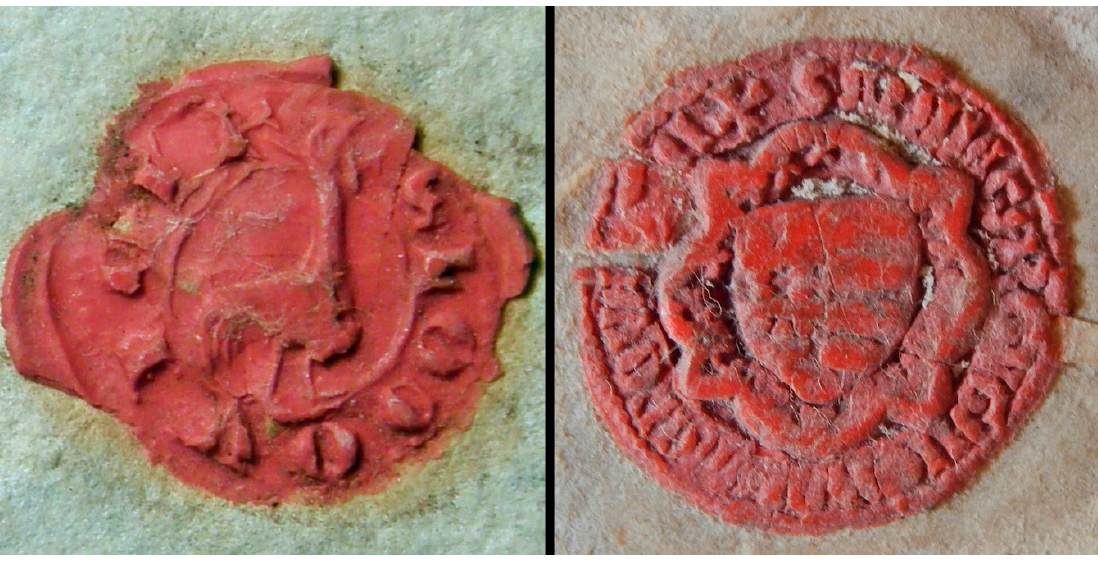
Figure 3. Signet ring seal of Louis the Great from 1360 ( left side ). Archiv mesta Košice, Archivum Secretum, “T” Jesznei, Nr. 26. The secret seal of Queen Mary of Hungary from 1387 ( right side ). Štátny archív v Prešove, Archive of the Drugeth family of Homonna, Nr. 14. Red wax seals of foreign rulers from around the country appear on the diplomas kept in Hungarian archives; for example, the seal of the Serbian despot Đ ura đ Brankovi´c is one of these.